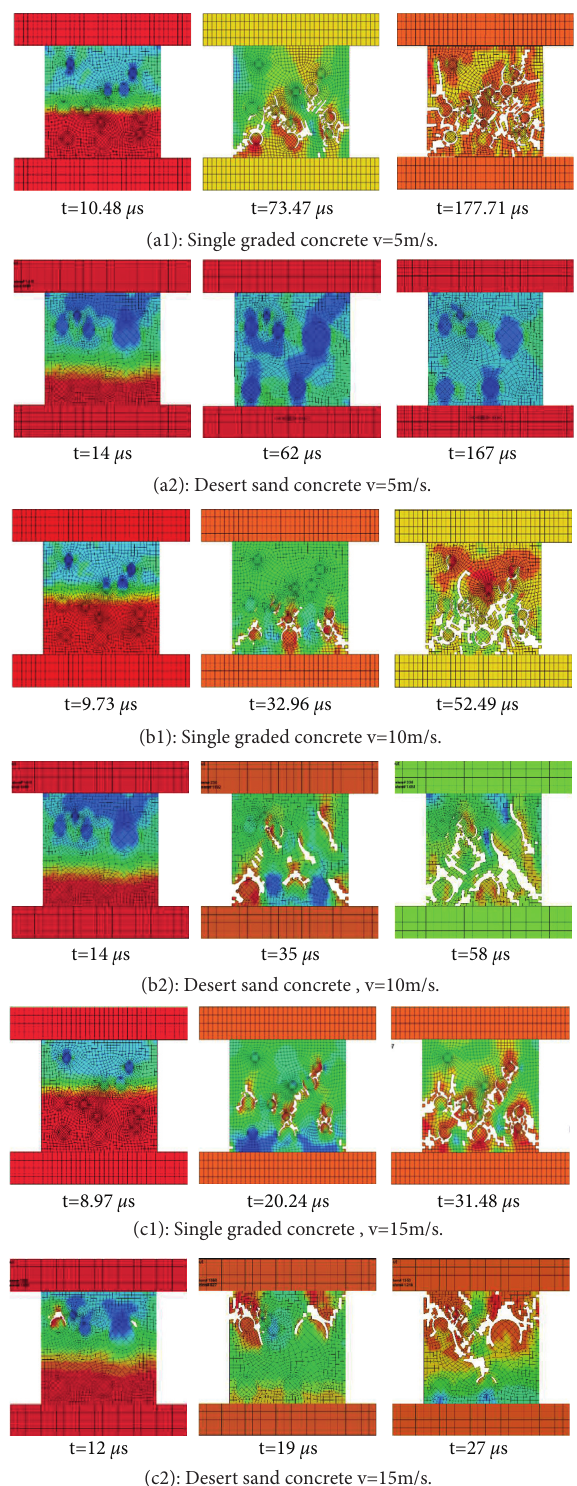
Figure 8: Impact failure process of desert sand concrete and single- graded concrete (74mm diameter, 70mm height